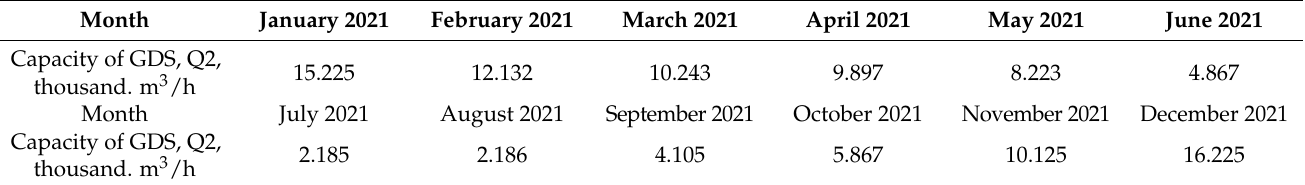
Table 7. Capacity of GDS.